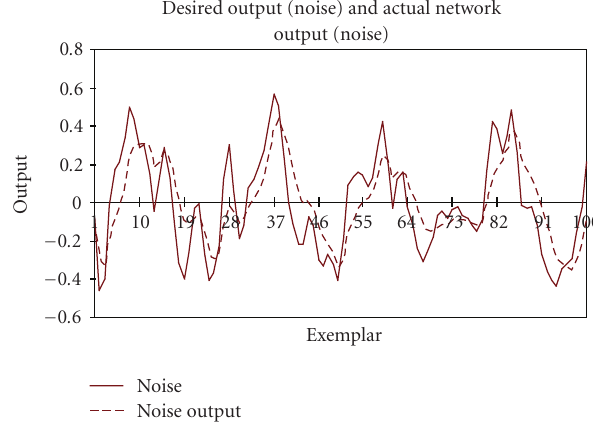
Figure 5: Modeling capability of MLP NN on testing dataset for EMG noise signal.